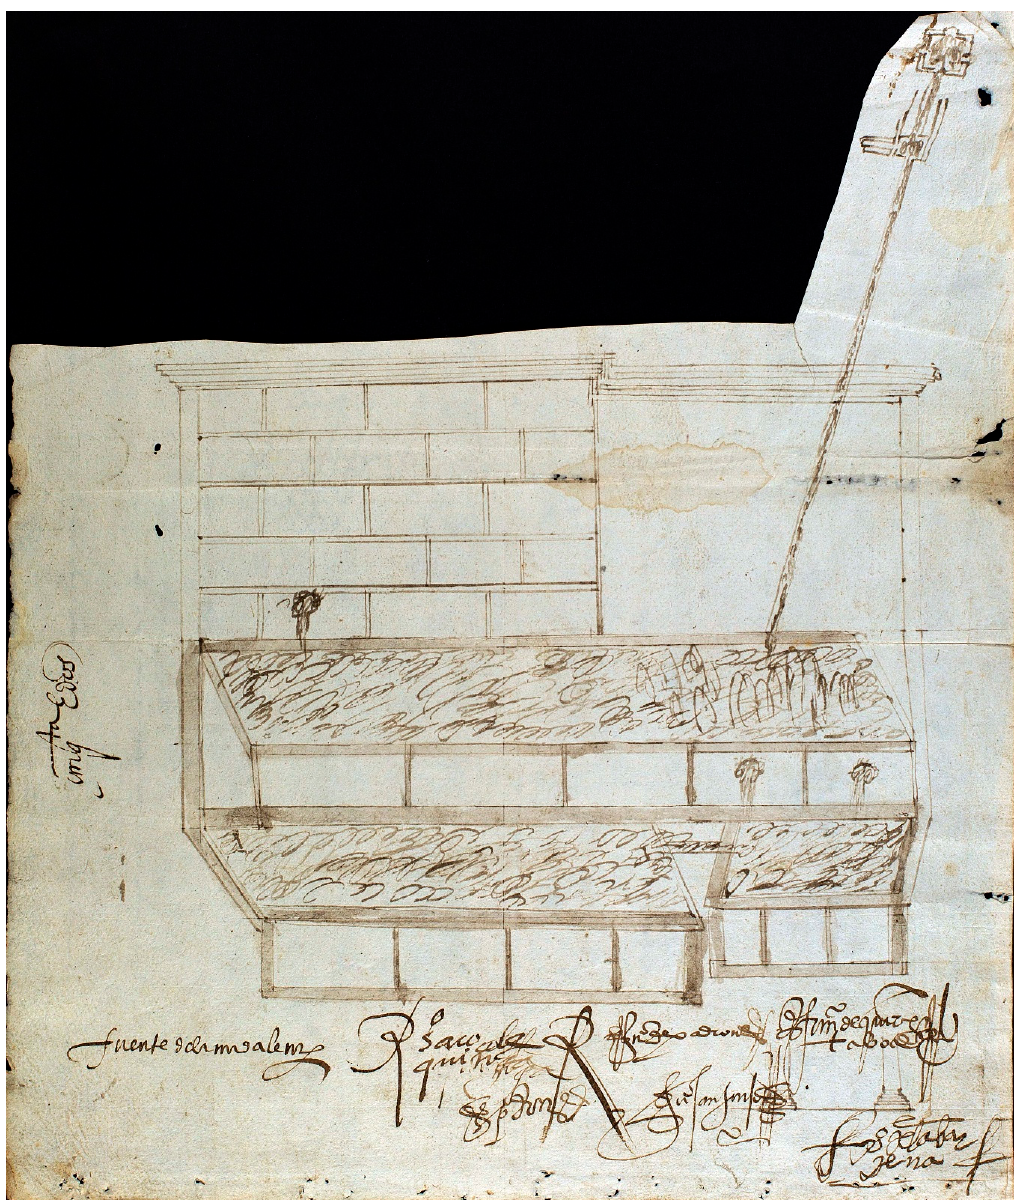
Figure 10. Drawings of the Magdalena Fountain, Gonzalo de la Bárcena, 1583. Provincial Historical Archive of Lugo: Maps, plans and drawings, No. 2.